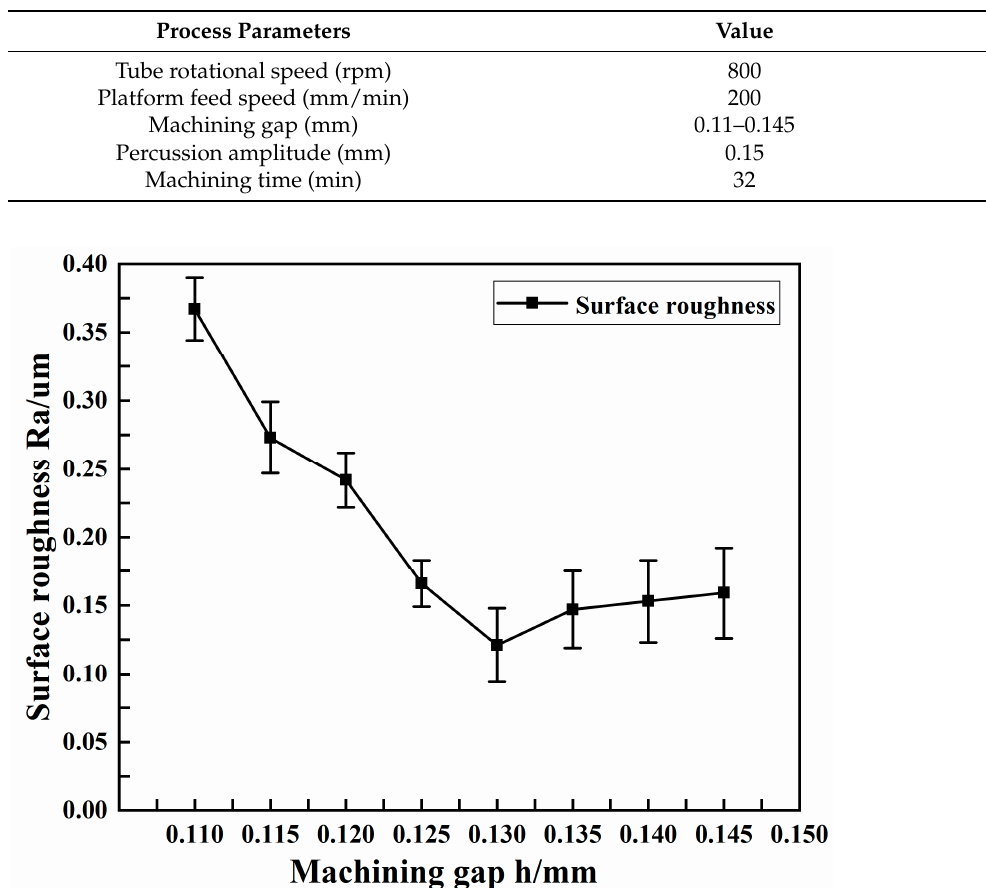
Table 6. Experimental conditions selected for different machining gaps.